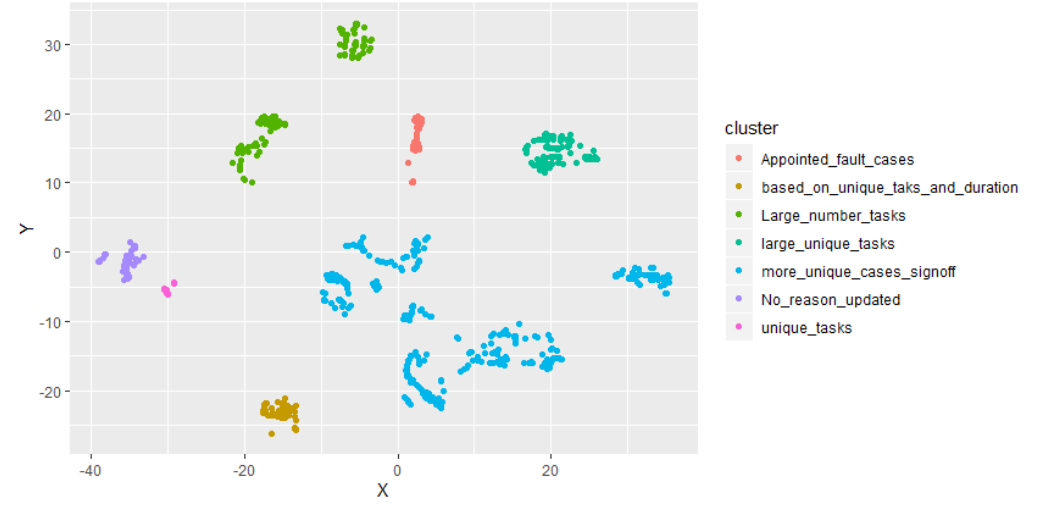
Figure 15. PSTN customer’s identified clusters among 844